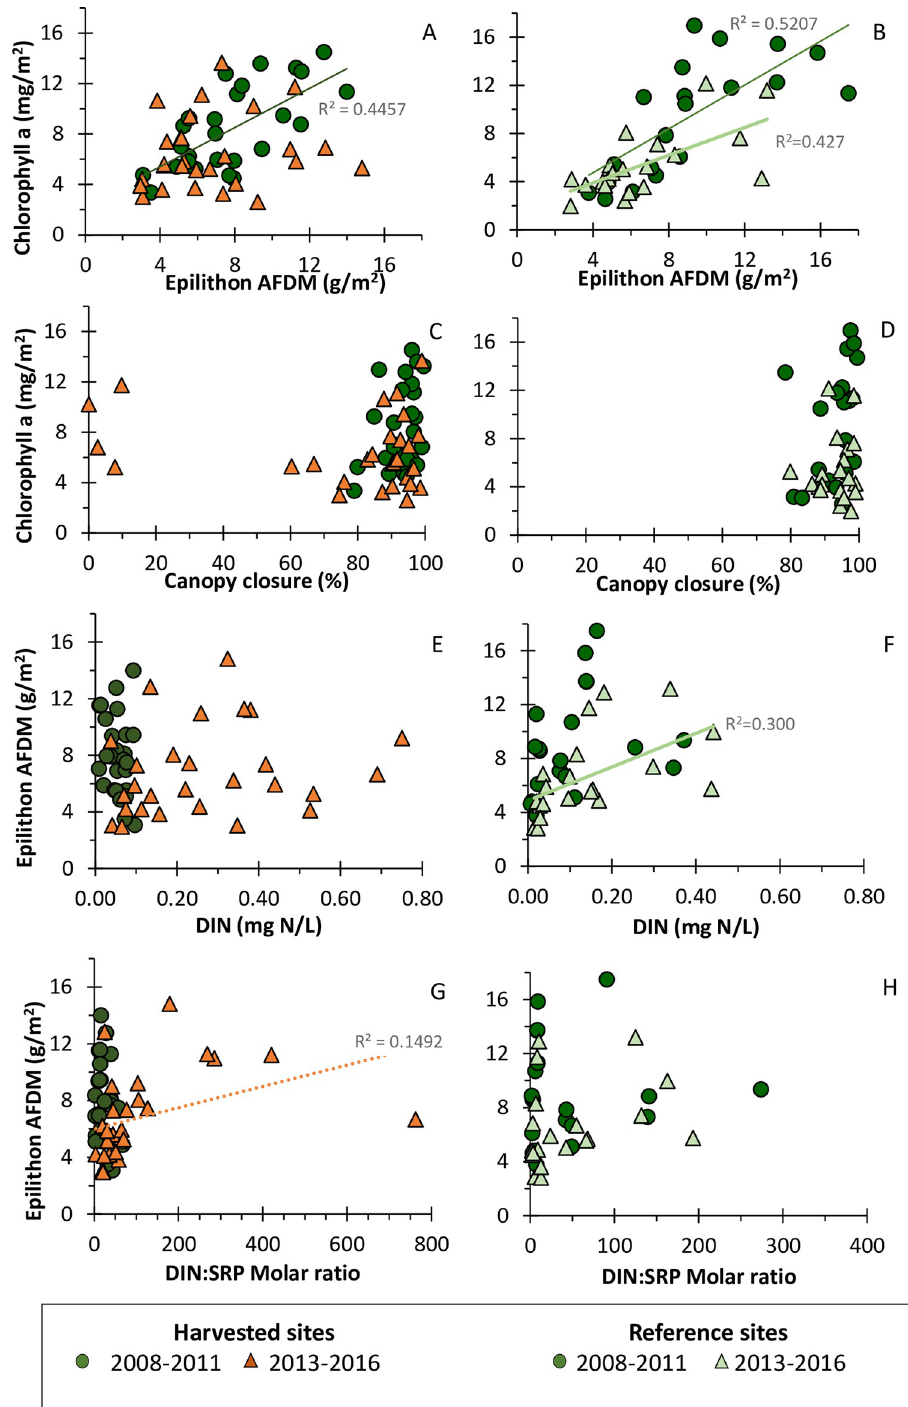
Fig 8. Correlations between chlorophyll a , epilithon and instream factors at headwater sites. These correlations compare site averages for each year and site during pre- and post-harvest periods. Headwater sites that were harvested are in the left column (A, C, E, G) and those were reference sites are in the right column (B, D, F, H). Chlorophyll a versus epilithon (A, B); Chlorophyll a versus canopy closure (C, D); Epilithon versus DIN (E, F); Epilithon versus molar ratios of DIN:SRP (Dissolved Inorganic Nitrogen: Soluble Reactive Phosphorus) (G, H). Data from pre-harvest period are indicated as dark green circles and from the post-harvest period are shown as triangles. R 2 values are included for the correlations where p-values are equal to or less than